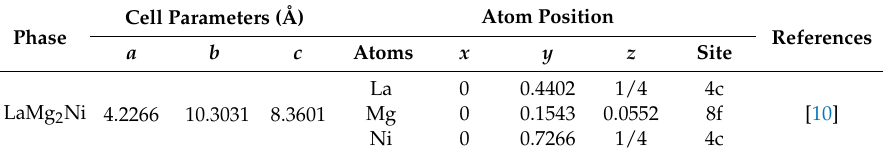
Table 1. X-ray structure refinement results on a single crystal of LaMg 2 Ni.